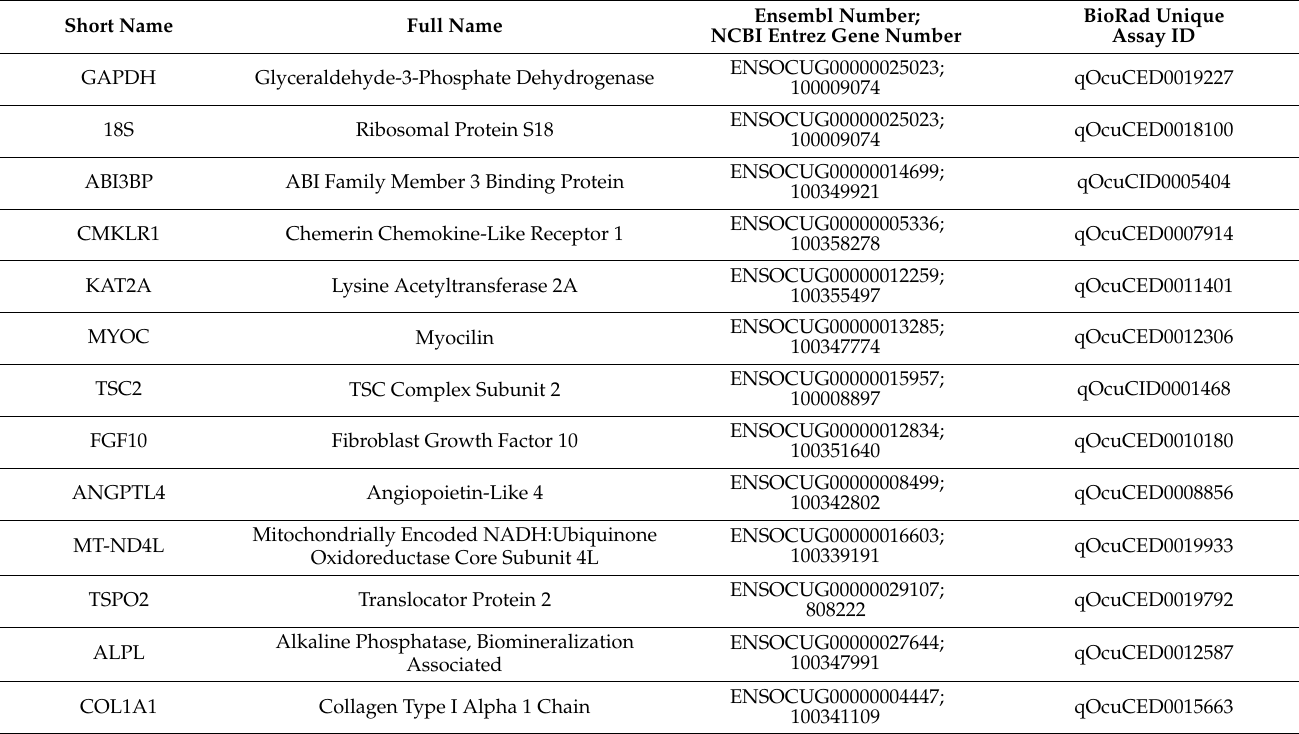
Figure 5. Relative expression of genes related to the osteogenic pathway in Fil050G- and Fil125G- related samples after 10 days of implantation; ( A ) Alkaline Phosphatase, ( B ) Collagen Type I Alpha 1 Chain, ( C ) RUNX Family Transcription Factor 2, ( D ) Osteopontin, ( E ) Osterix, and ( F ) Caveolin-1. p -values are indicated as follow; * p < 0.05, ** p < 0.01. Table 6. List of primers used in this study, with their short name, full name, Ensembl number, NCBI Entrez Gene number, and BioRad unique assay ID.